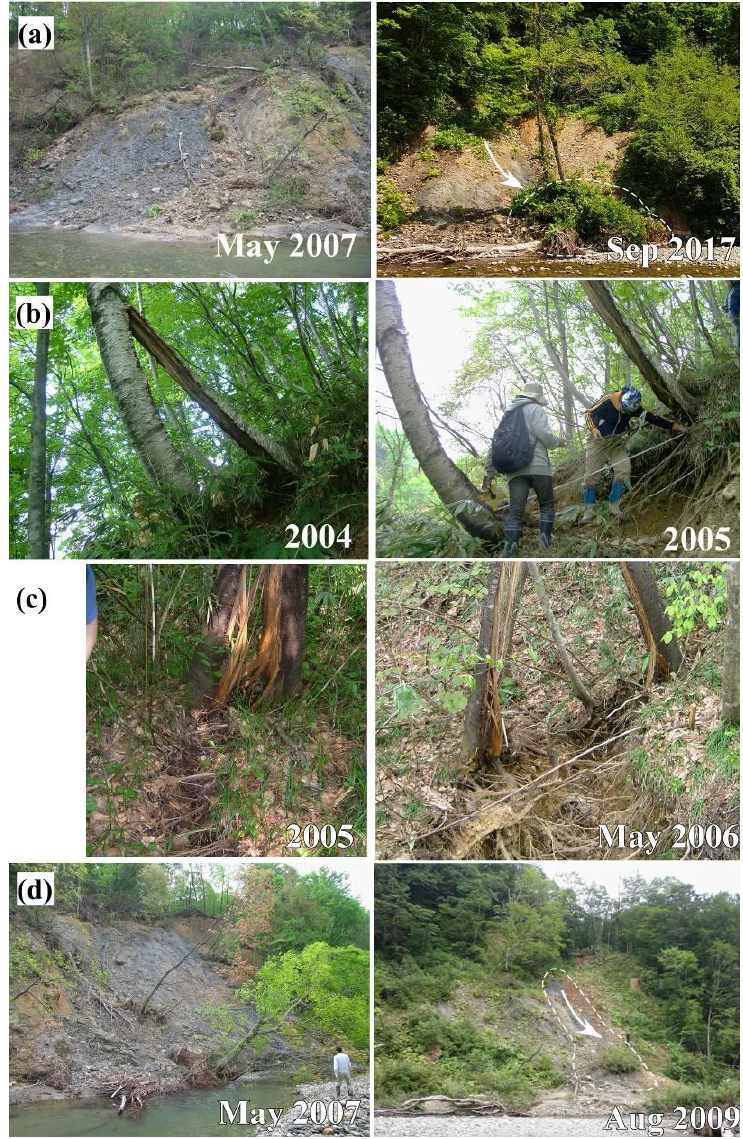
Figure 9. Representative examples of slope movements in the study area. ( a ) Ongoing movement on the downslope part of the northern section of the Ohkawa landslide. ( b ) Enlargement of about 2 m tension crack identified in the landslide scarp of the eastern section of the Ohkawa landslide. ( c ) Close-up view of the tension crack. The crack became the lateral scarp of the southern section of the Ohkawa landslide and had enlarged to about 20 m by July 2006. ( d ) A disrupted slide in the downslope part of the southern section of the Ohkawa landslide. The month and year in which photographs were taken are indicated at bottom-right in each panel. Locations of the photographs are indicated in Figure 8.